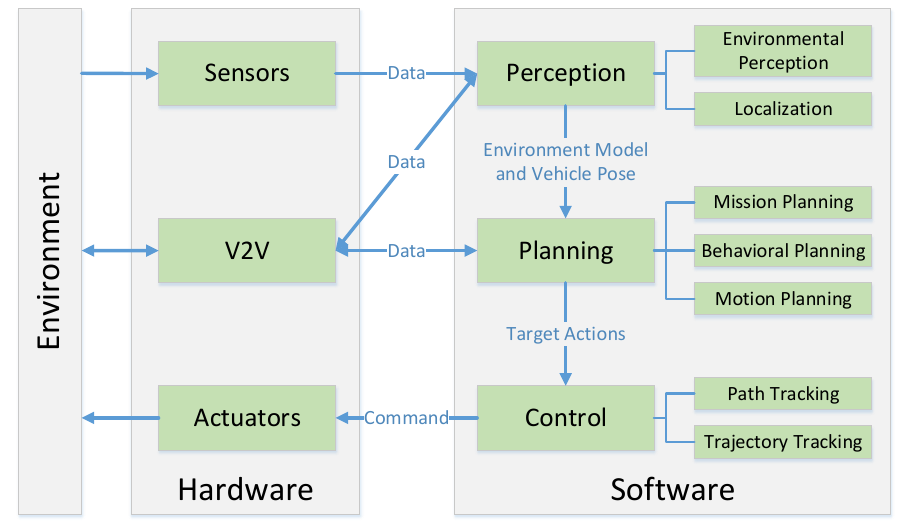
Figure 2. A typical autonomous vehicle system overview, highlighting core